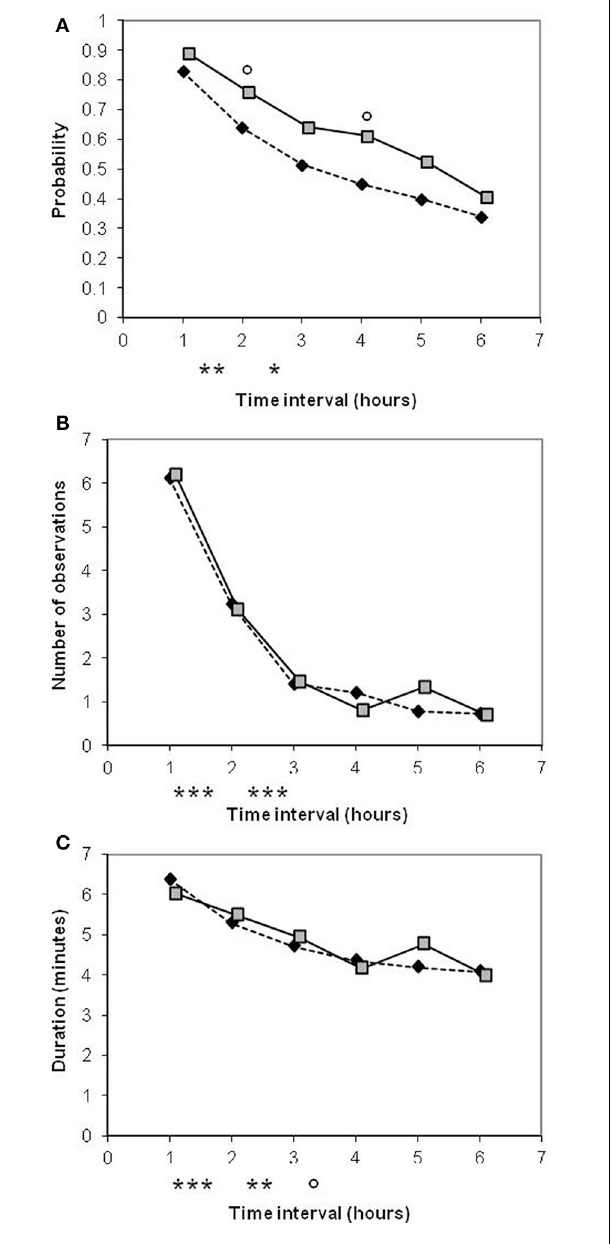
FIGURE 5 | Comparison of old-type sows ( (cid:2) ) and modern-type sows ( ) for maternal responsiveness (A) and maternal attentiveness occurence (B) and duration (C) during the first 6h after the onset of farrowing. Significance levels below the X axis refer to differences between successive periods of time, obtained with both lines merged together. Significance levels reported on the graph above mean values refer to line differences: ◦ P < 0 . 10; ∗ P < 0 . 05; ∗∗ P < 0 . 01; ∗∗∗ P < 0 .